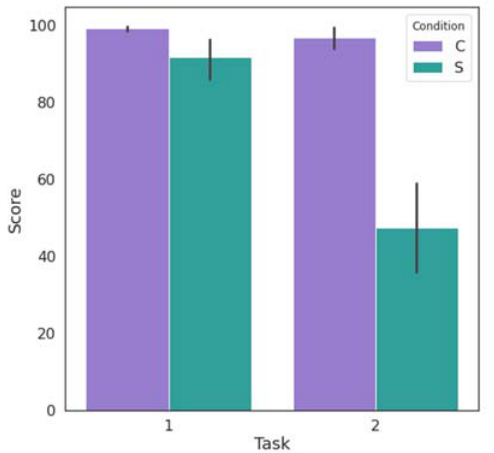
Figure 10. The average scores of all the subjects during the control (C) and the stress (S) conditions of the Stroop Color Word Task (Task 1) and the Mental Arithmetic Task (Task 2). Bar lines indicate the standard deviation values.